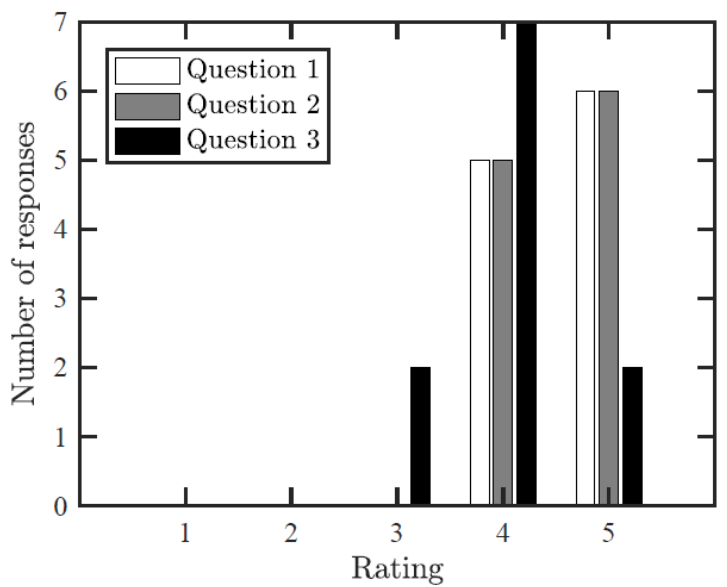
Figure 9. Bar chart reflecting answers to survey questions. The scale for each question was from 1–5 with 1 being the lowest.